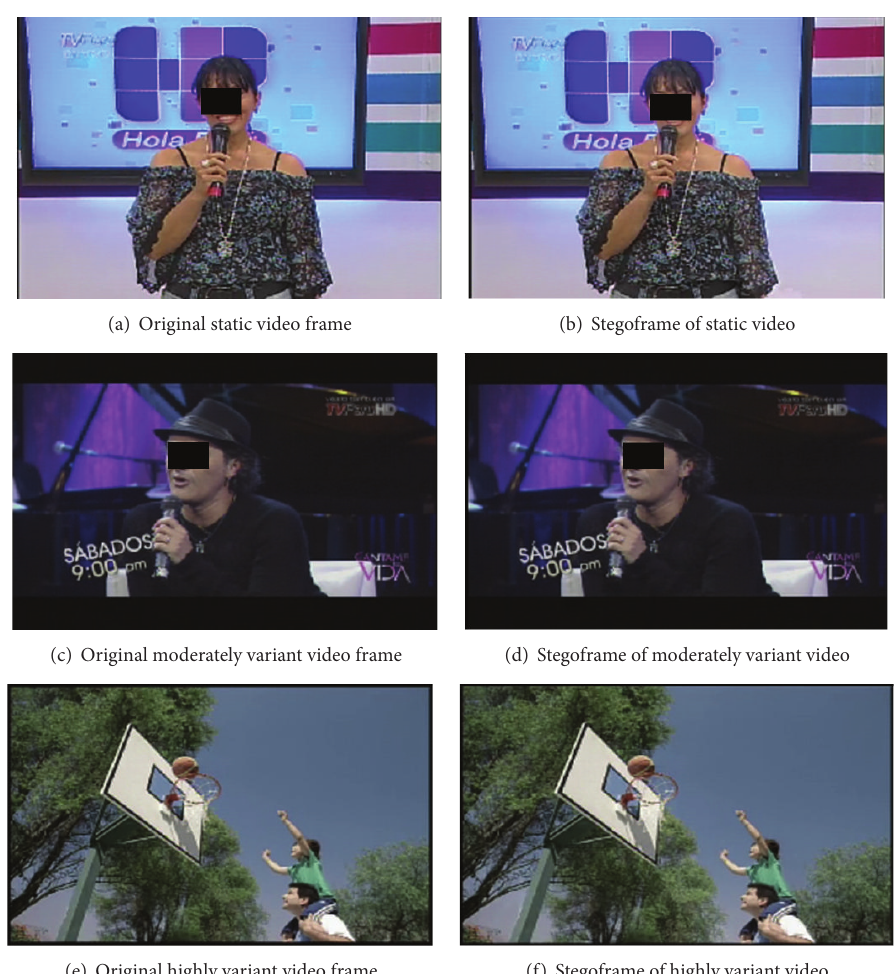
Figure 5: Stegovideo frames excerpts after hiding a secret message (secret data of 80-byte length: “ the two companies are at the forefront of a tantalizing wireless communications concept that has proved hard to produce on a big scale: reduce cellphone costs by relying on strategically placed Wi-Fi routers. And when there are no routers available, fall back on the traditional cellular network ”).